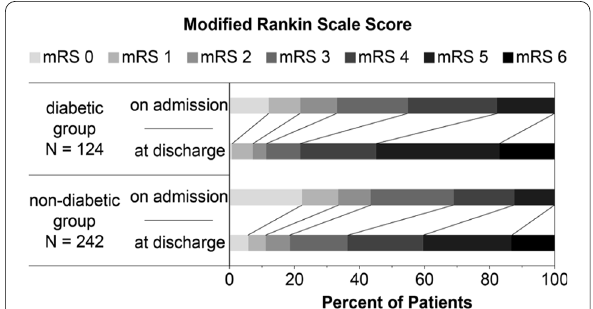
Fig. 2 Distribution of mRS scores in both groups patients with or without diabetes. Abbreviations: mRS, modified Rankin